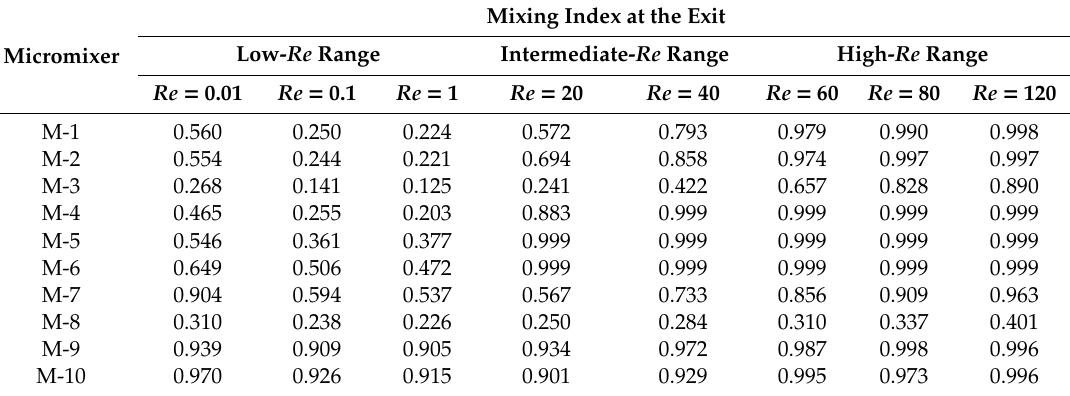
Table 4. Mixing index at the exit.